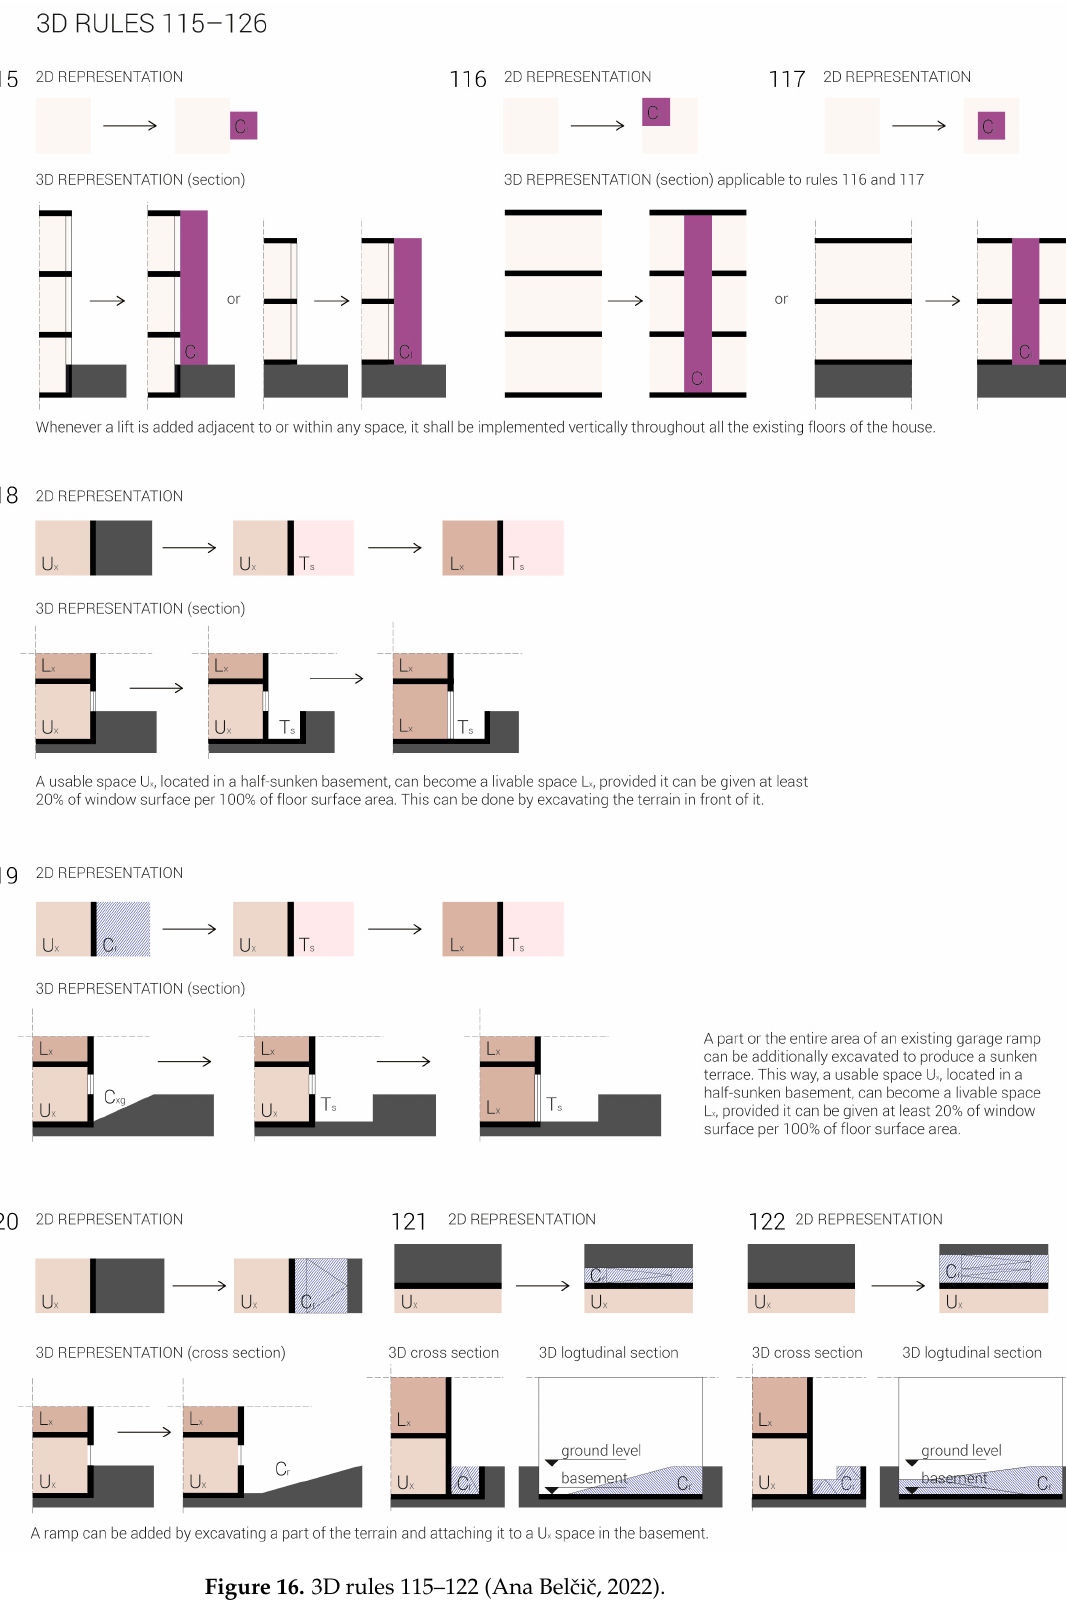
Figure 16. 3D rules 115–122 (Ana Bel č i č , 2022).